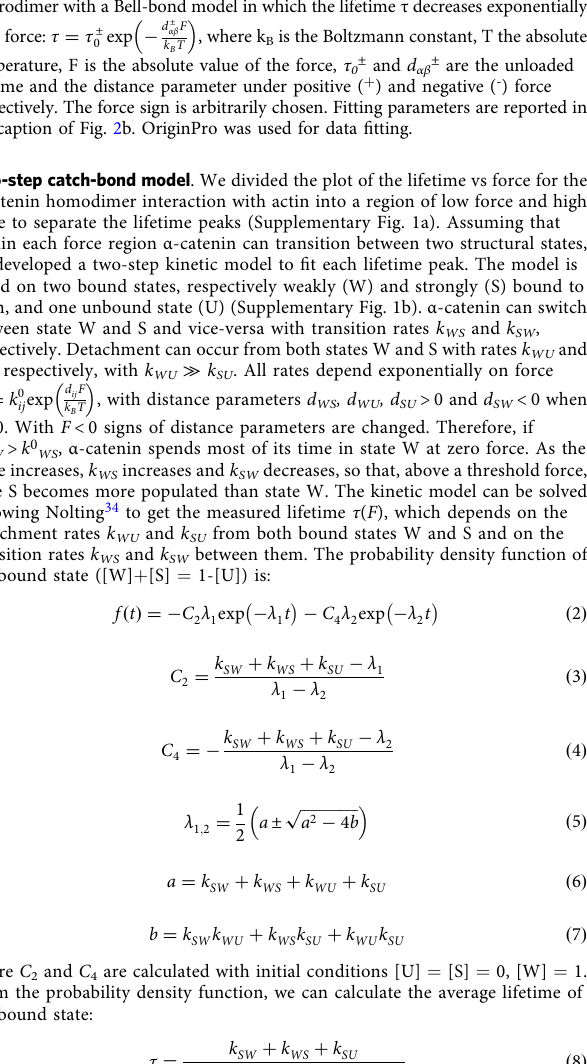
Supplementary Table 1. OriginPro was used for data fi